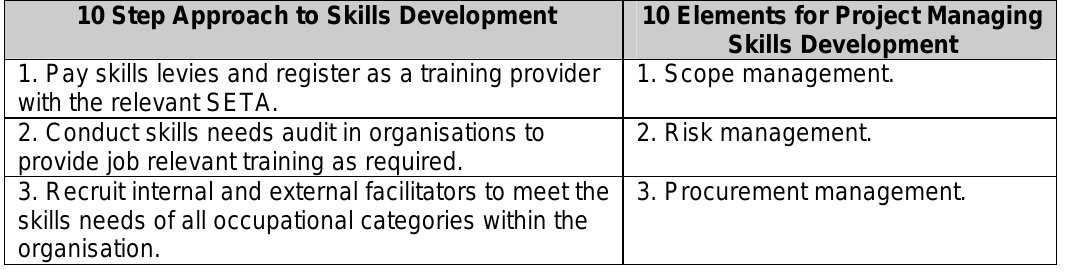
Table 5: The proposed skills management framework for improving workplace skills development 10 Step Approach to Skills